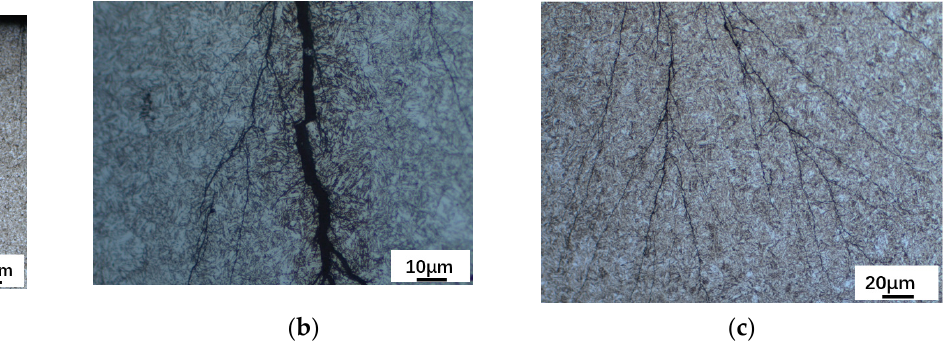
Figure 6. Macromorphology of the Inner Surface of the Tubing after Corrosion Observed by ZSA302 Stereomicroscope. ( a ) Cracks on the Inner Surface of Tubing (200 μ m). ( b ) Cracks on the Inner Surface of Tubing (10 μ m). ( c ) Cracks on the Inner Surface of Tubing (20 μ m).